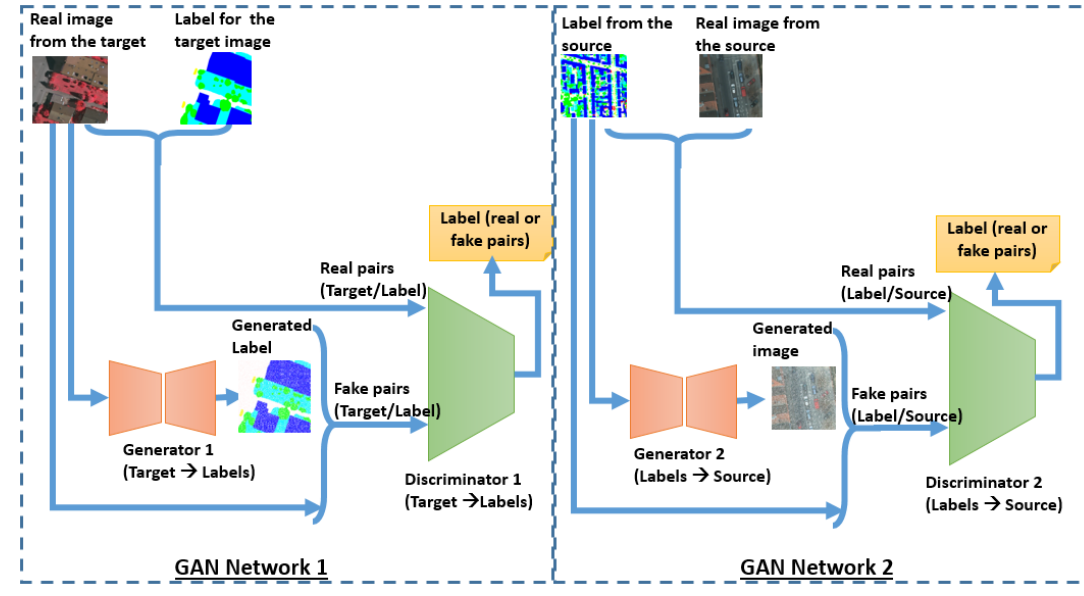
Figure 3. The GAN